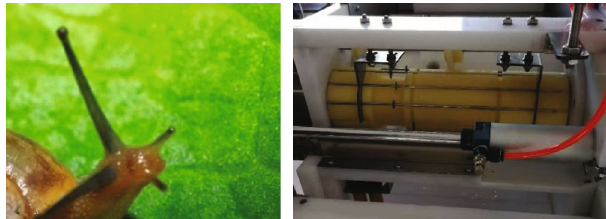
Figure 11: The biological prototype of the skewer-pushing structure.